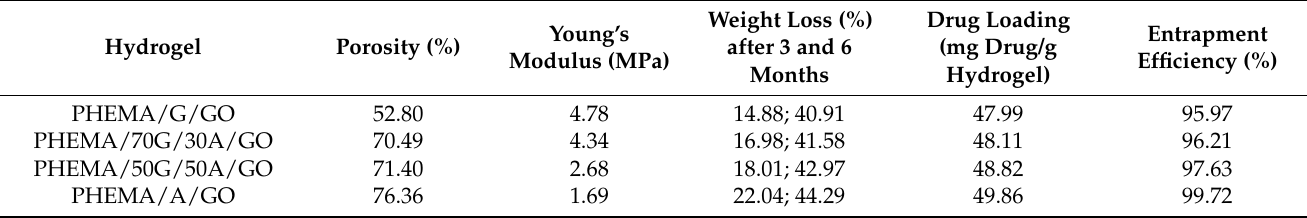
Table 1. Obtained results of porosity, Young’s modulus, weight loss (%) after 3 and 6 months, drug loading and entrapment efficiency of the hybrid